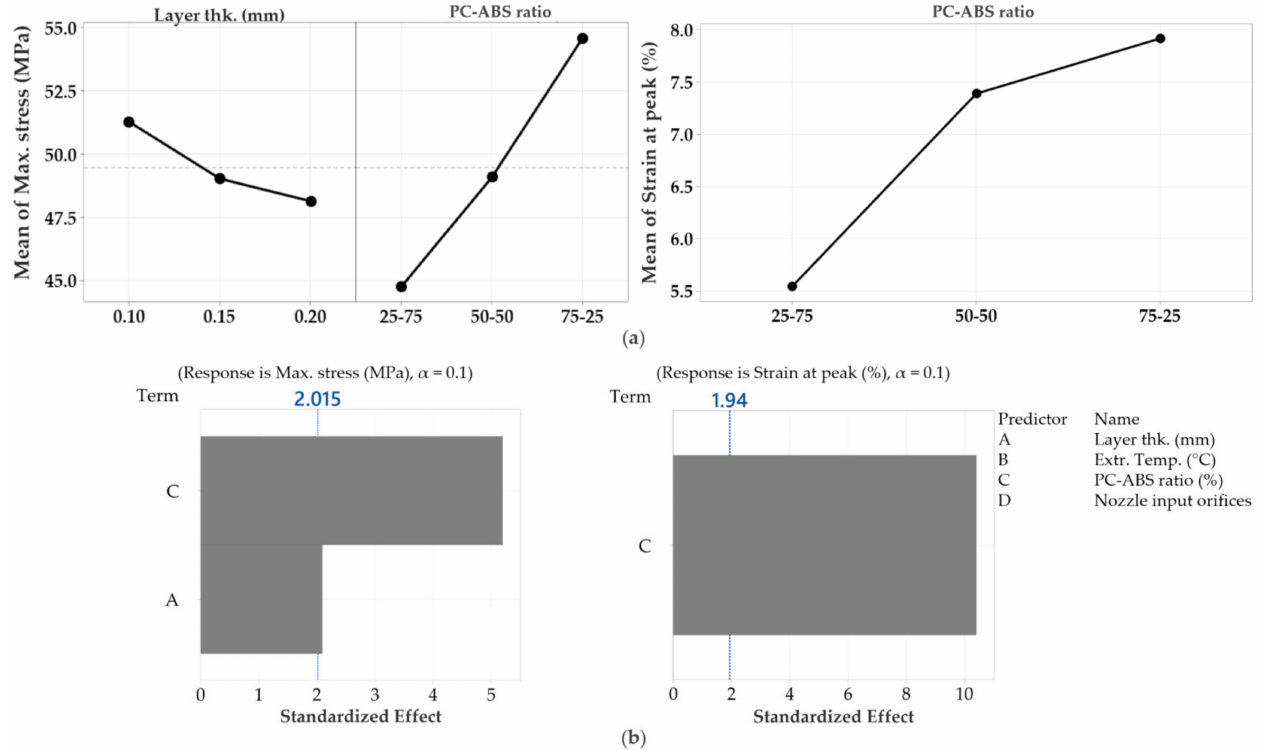
Figure 8. ( a ) Main effects plots of the variables. ( b ) Pareto chart of the standardised